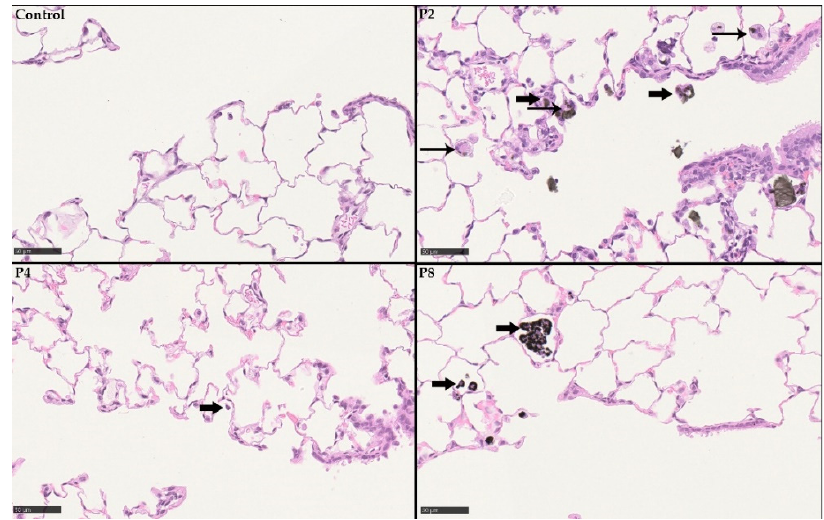
Figure 12. Histopathological findings at day 29 post-exposure following 28 days of inhalation. Control without any histopathological findings. P2 (SLG) high-dose group with particle-laden macrophages (bold black arrows) and particle-laden giant cells (syncytia; black arrow). P4 (GNP) high-dose group with particle-laden macrophages (bold black arrows). P8 (CB) also with particle-laden macrophages (bold black arrows).